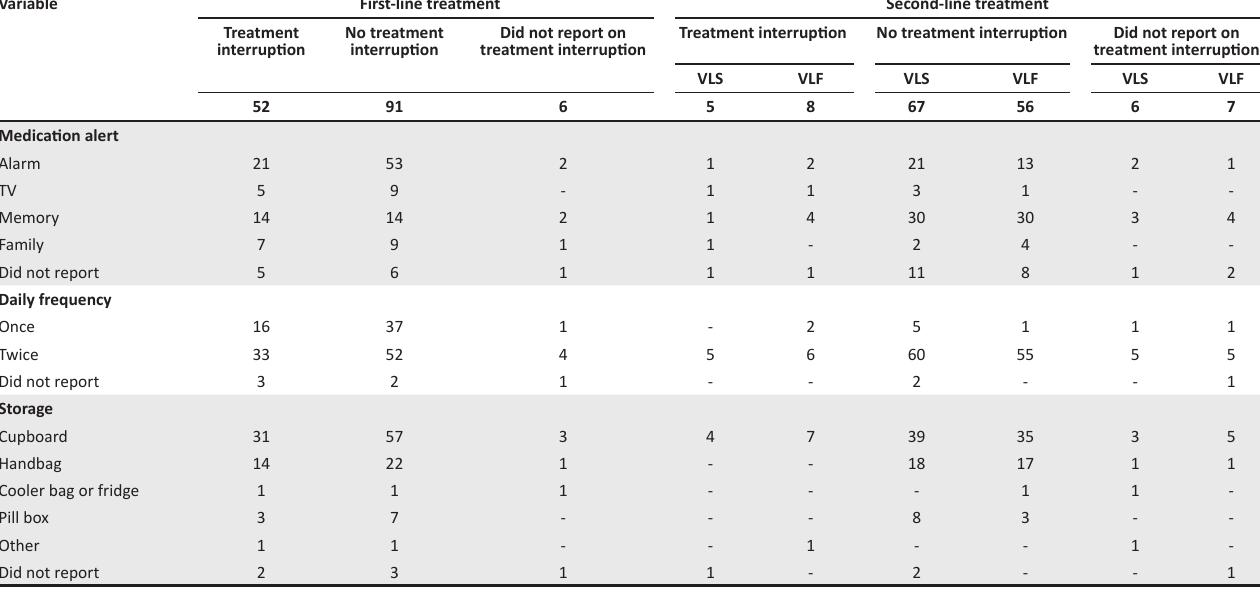
TABLE 3: History of antiretroviral treatment-taking